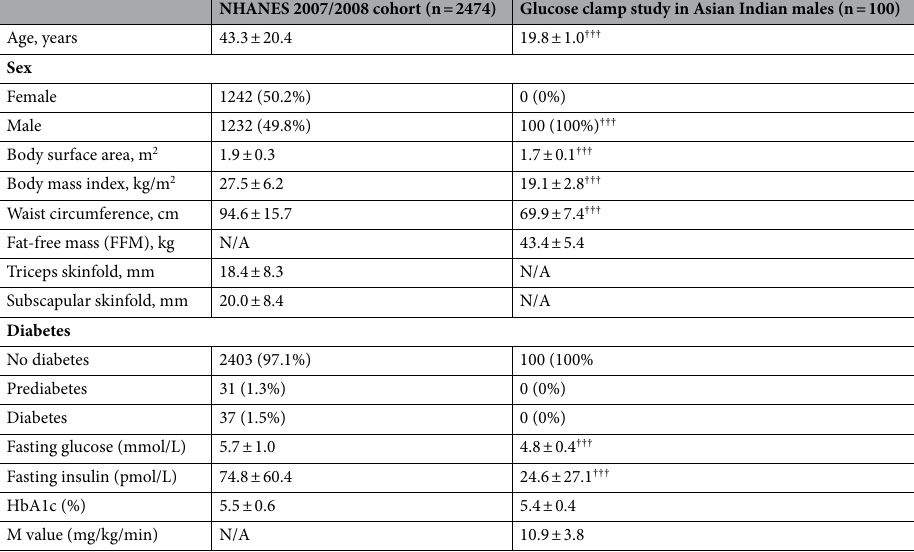
Table 2. Clinical characteristics of the two studied cohorts. Data are reported as mean ± SD or counts (percentage). ††† p < 1e–15 for the comparison of the cohorts.